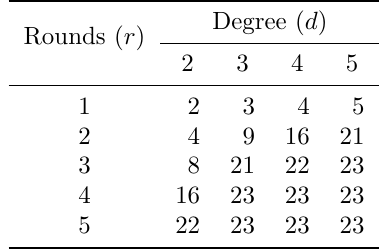
Table 7: Upper bounds on the ANF degree of outputs after r rounds using 6-bit S-boxes with degree of d in all the coordinates of the